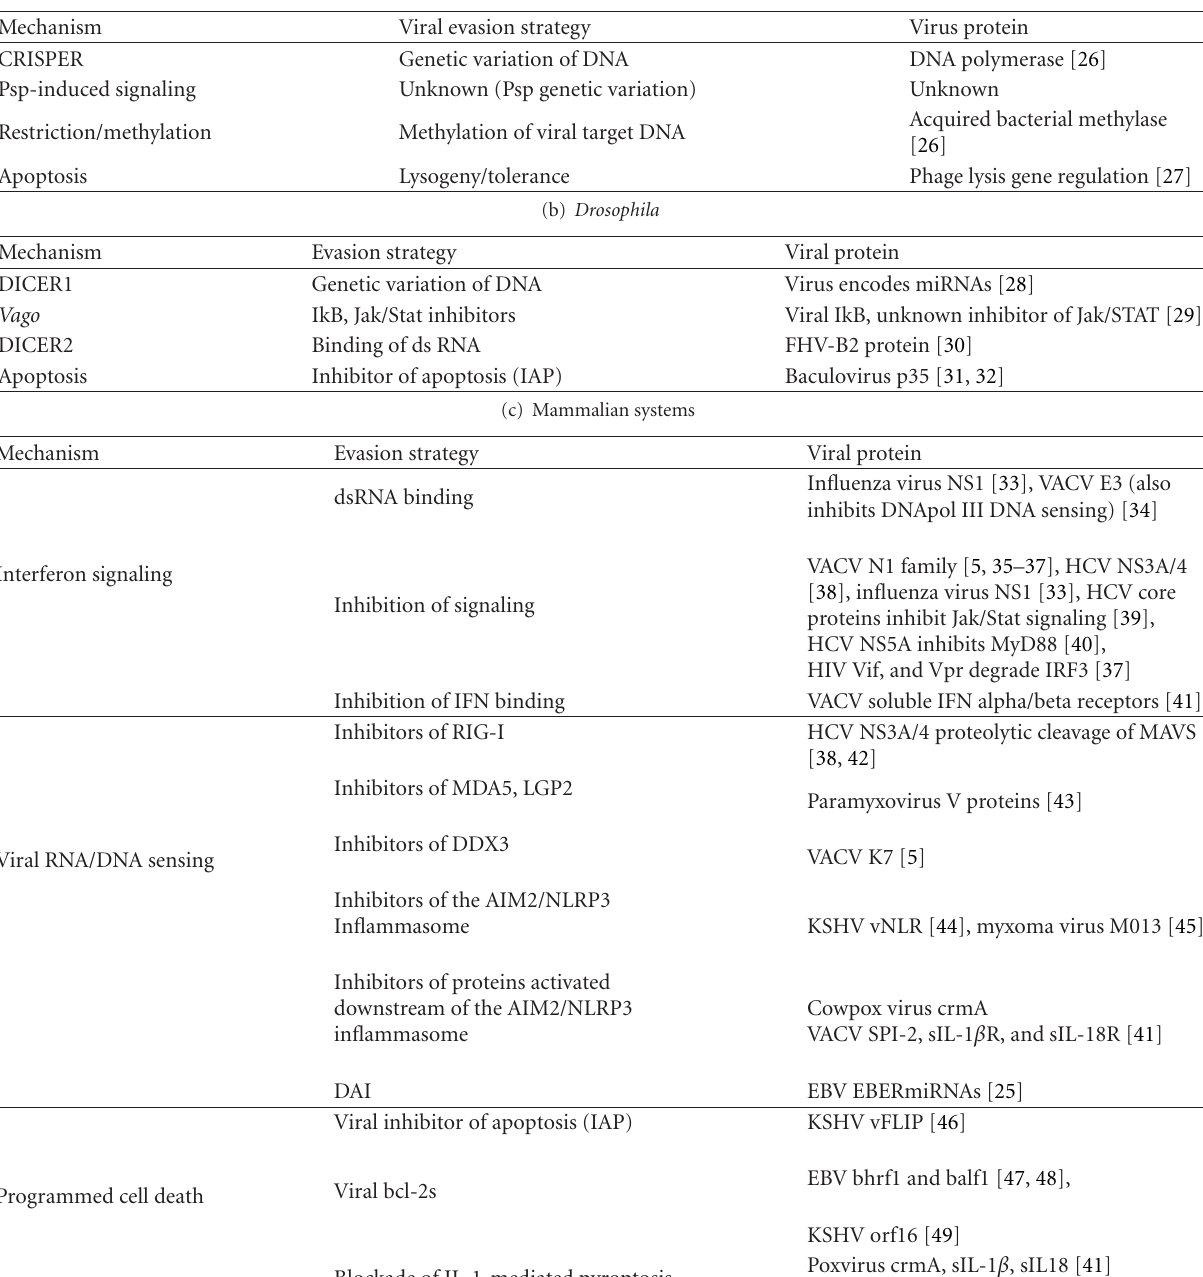
Table 1: Examples of parallel evolution of viral innate immune evasion